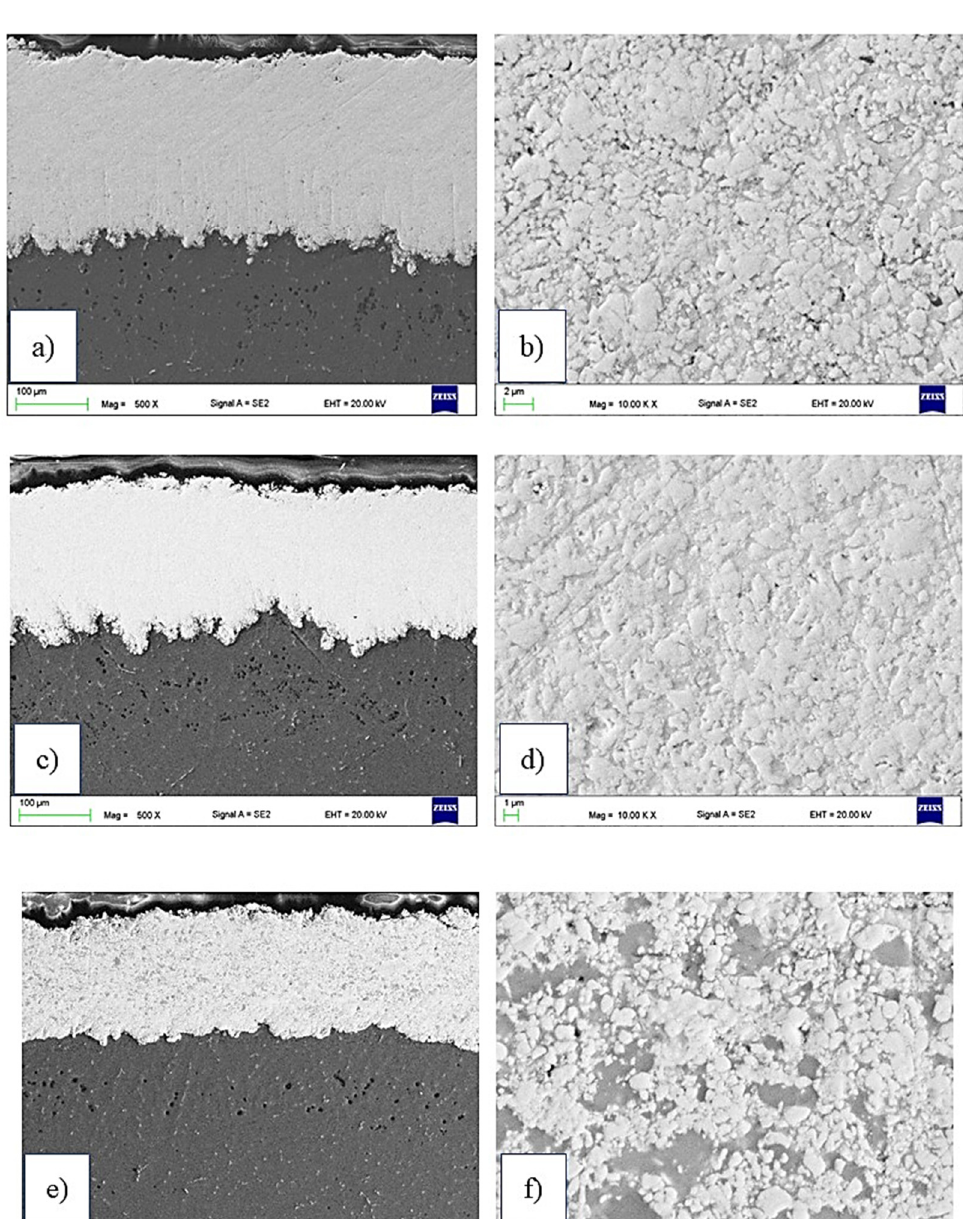
Figure 3. SEM images of cross-sections of HVOF-sprayed coatings: ( a , b ) C1, ( c , d ) C2, ( e , f ) C3 (( a , c , e )—mag. 500×; ( b , d , f )—mag. 10,000×).